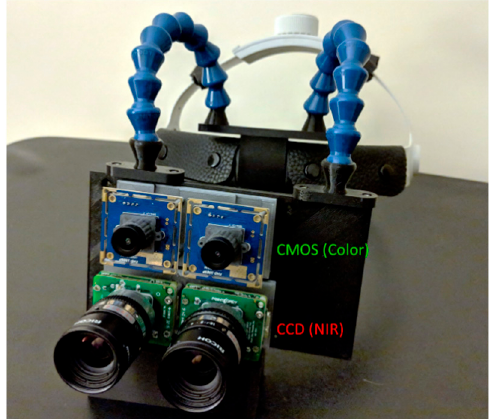
Figure 1. Head-mounted stereoscopic multimodal 3D optical imaging AR display system. Two CCD cameras are used for near-infrared (NIR) fluorescence imaging and two CMOS cameras are used for color reflectance imaging. The imaging module is connected to a loupe-style head mount.